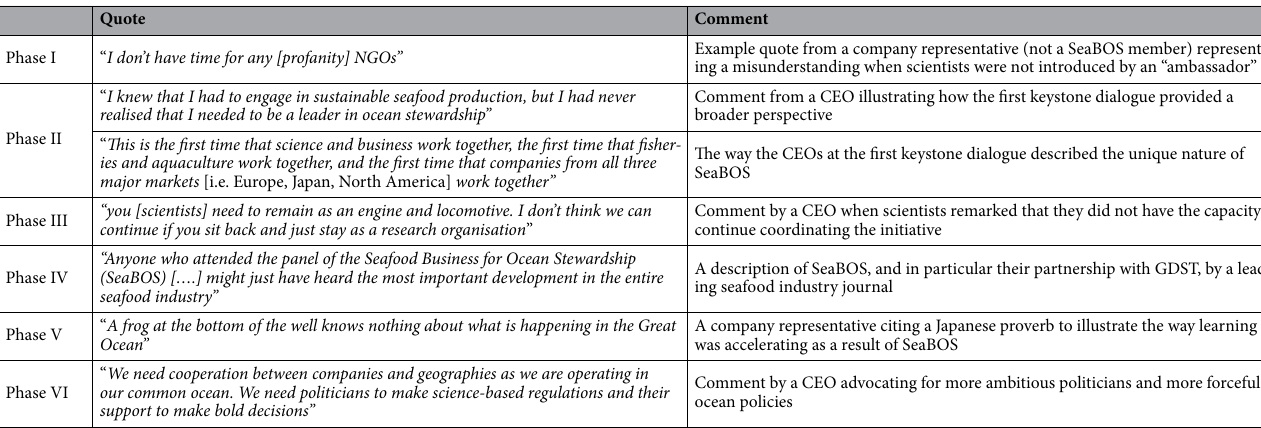
Table 1. Representative quotes from the described six